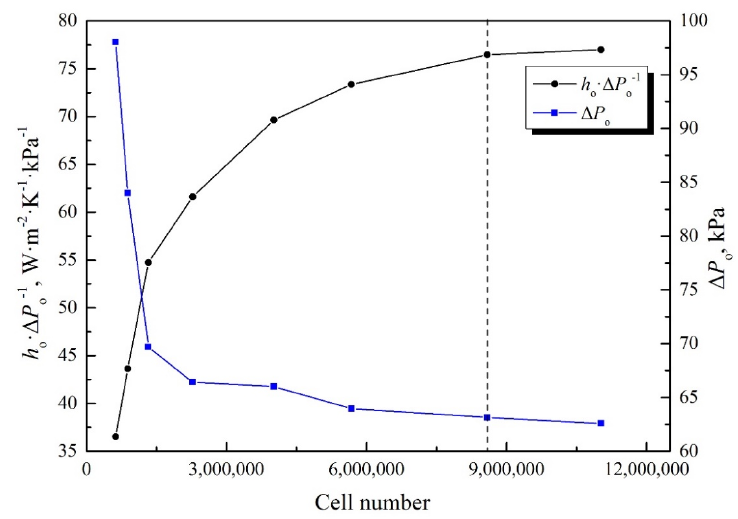
Figure 4. Results of different grid systems (base fluid, Re o = 480).